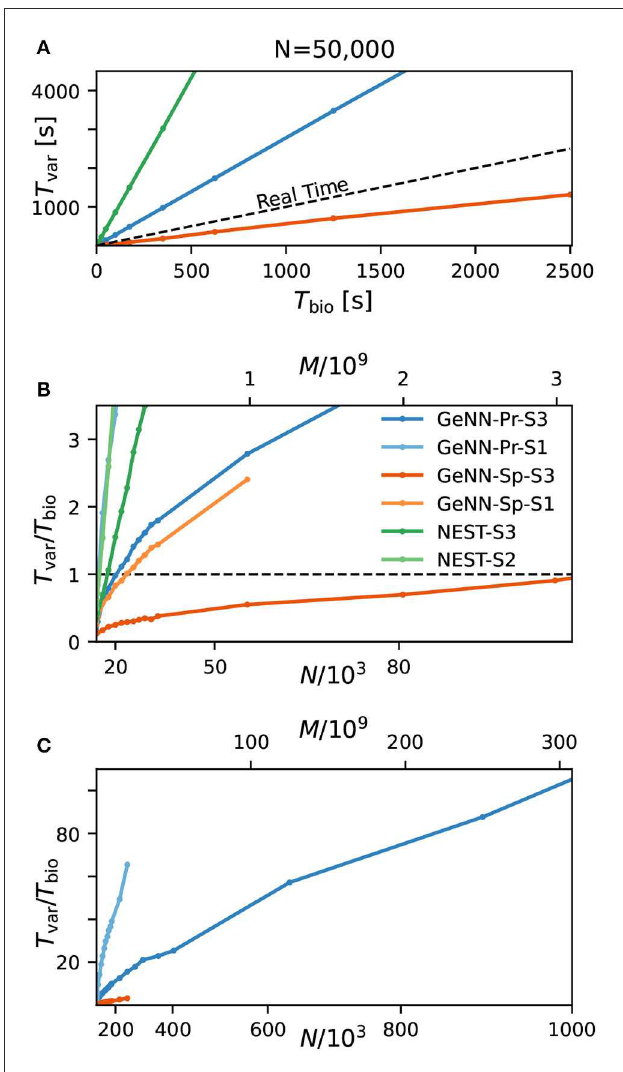
FIGURE3 Variable costs of simulation and real-time limitation. (A) Wall-clock time T var as a function of simulated biological model time T bio . (B) Real-time factor RT = T var / T bio as a function of network size. Real-time capability requires a variable cost factor that remains below RT = 1 (dashed line). On the high-end GPU, simulation faster than real-time can be achieved for a network size of N ≈ 100,000 neurons and M ≈ 3.1 · 10 9 synapses. With the best performing NEST configuration, a network of N ≈ 15,000 neurons and M ≈ 0.1 · 10 9 synapses can be simulated in real-time. GeNN-Pr-S1 is congruent with NEST-S2 in this view. (C) As in (B) for larger network size. Wall-clock time scales almost linearly with the total number of synapses M (and thus with N 2 ) for large network sizes. All simulations have been conducted with a time resolution of 1 t = 0.1ms in biological model time. (B, C) The x-axis is linear in M (top